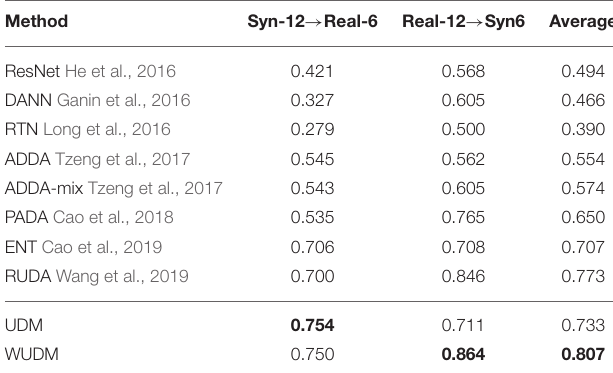
TABLE 2 | Partial domain adaptation on